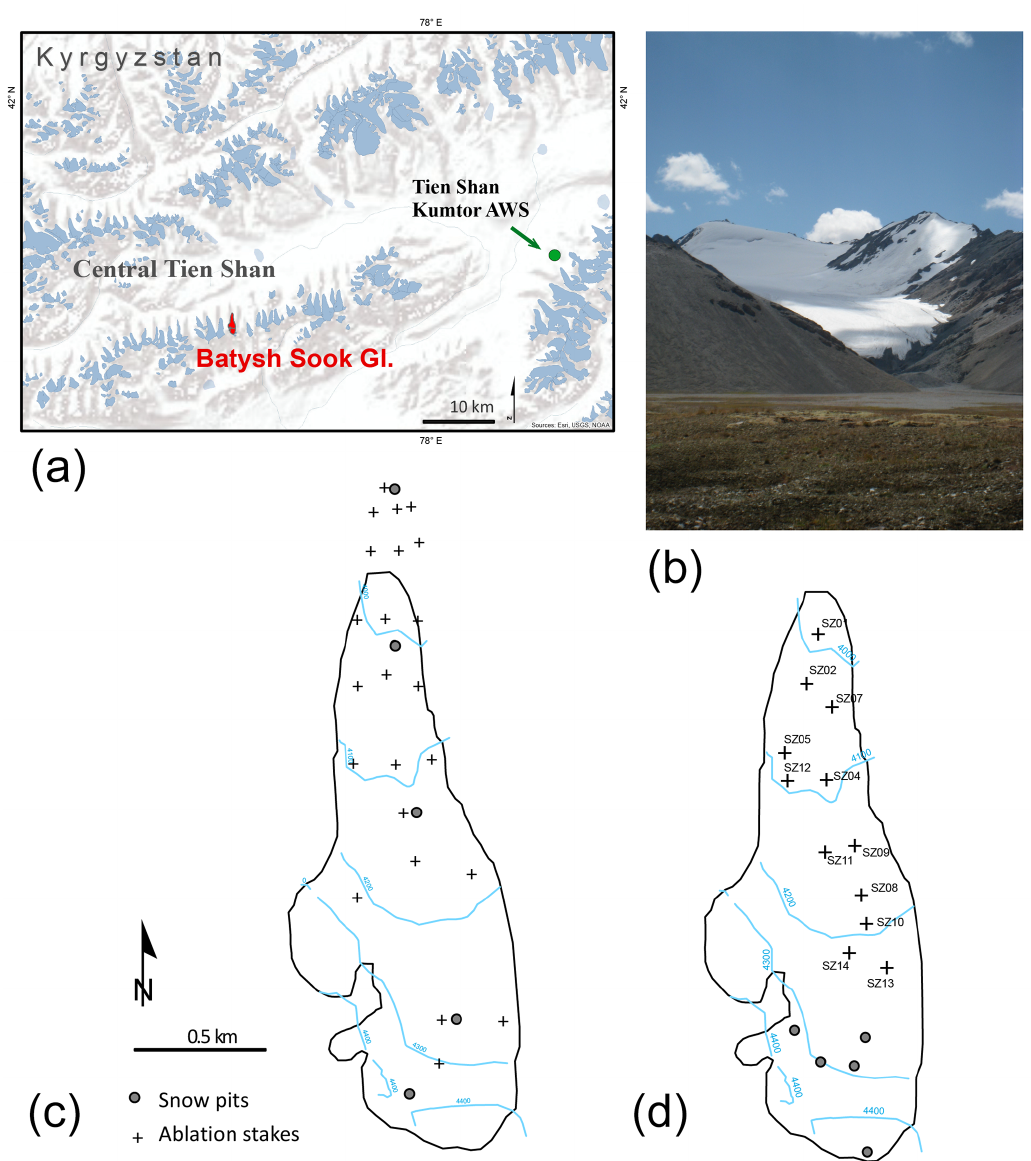
Figure 9. Historical (c) and new (d) mass balance network on the Batysh Sook glacier (Kyrgyzstan) with corresponding (overview) map (a) and picture (b)